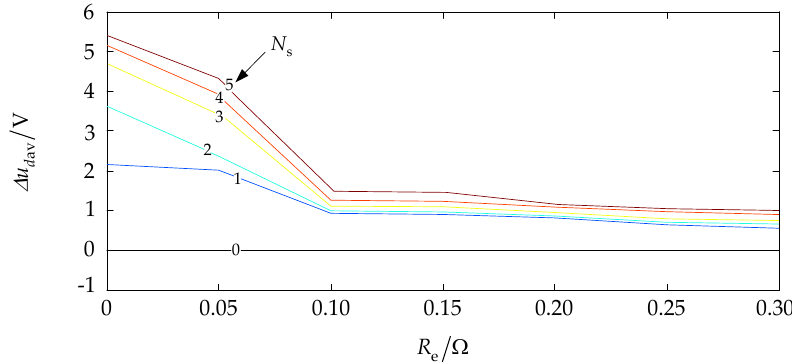
Figure 25. The variation curves of ∆ u d av with the number of short-circuited turns and the external contact resistance.